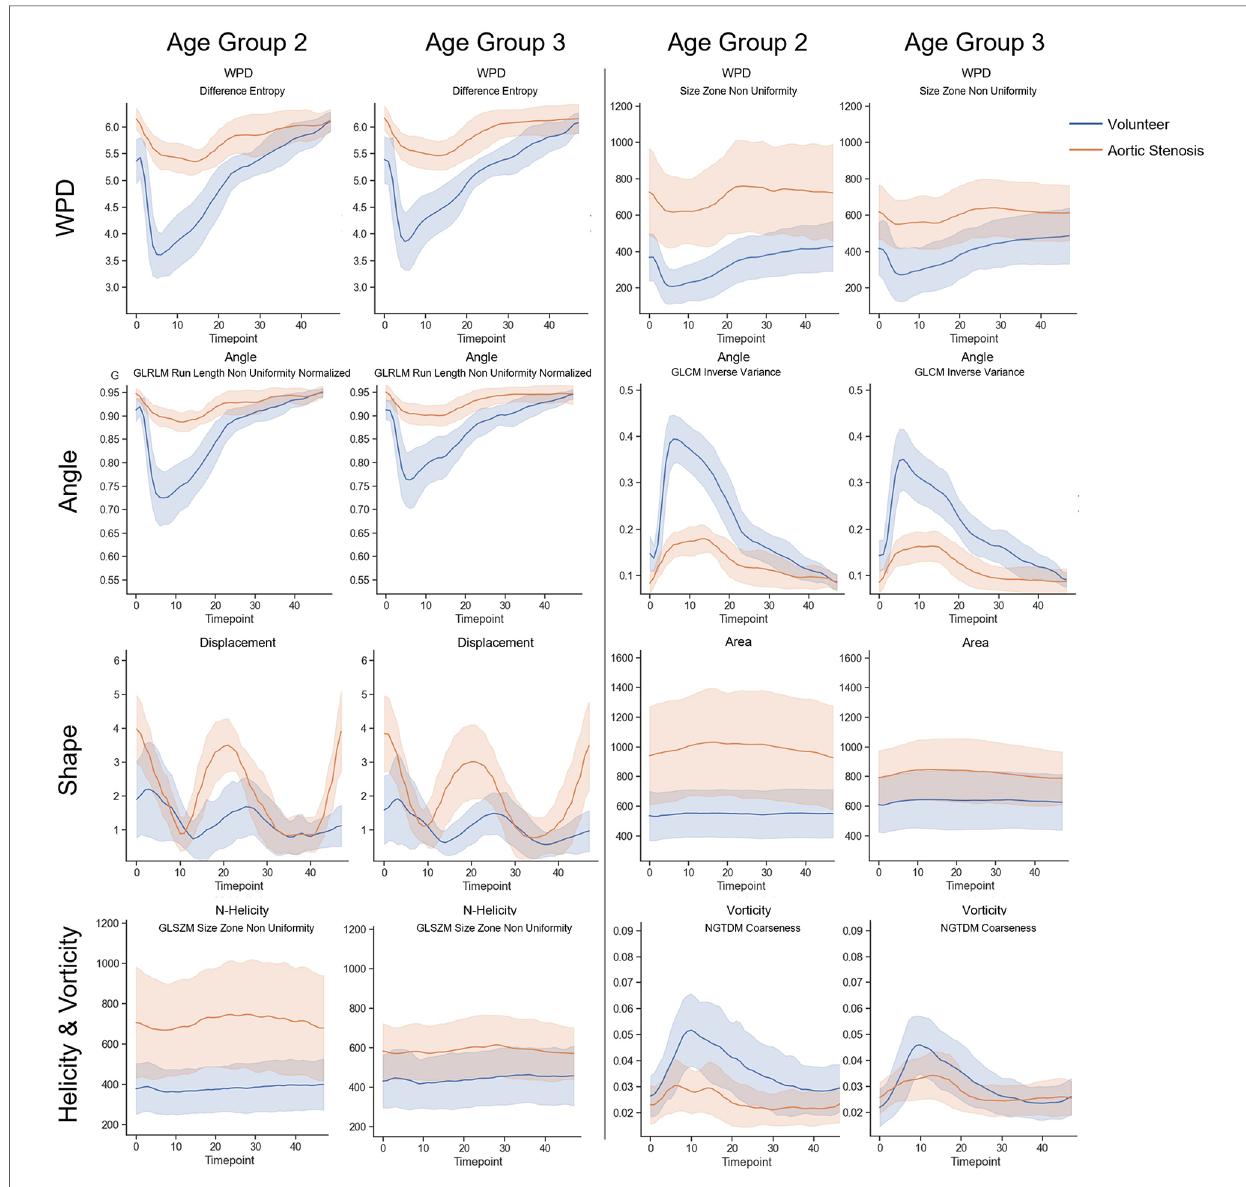
FIGURE 4 Comparison of radiomics feature value ranges for patients with aortic valve stenosis (cohort2: orange) and age-matched subjects from the population without valve diseases (cohort3: blue). The curves in row 1 show radiomics parameters extracted on WPD parameter maps over the complete cardiac cycle in age group 2 (40 – 59), and and in age group 3 (60 – 80). Together with with the parameters shown in row two, which were extracted from fl ow angle maps, these selected features describe patterns related to the fl ow direction. The parameters in row three describe the shape and motion, while the parameters in row four describe patterns related to normalized helicity and vorticity-related patterns